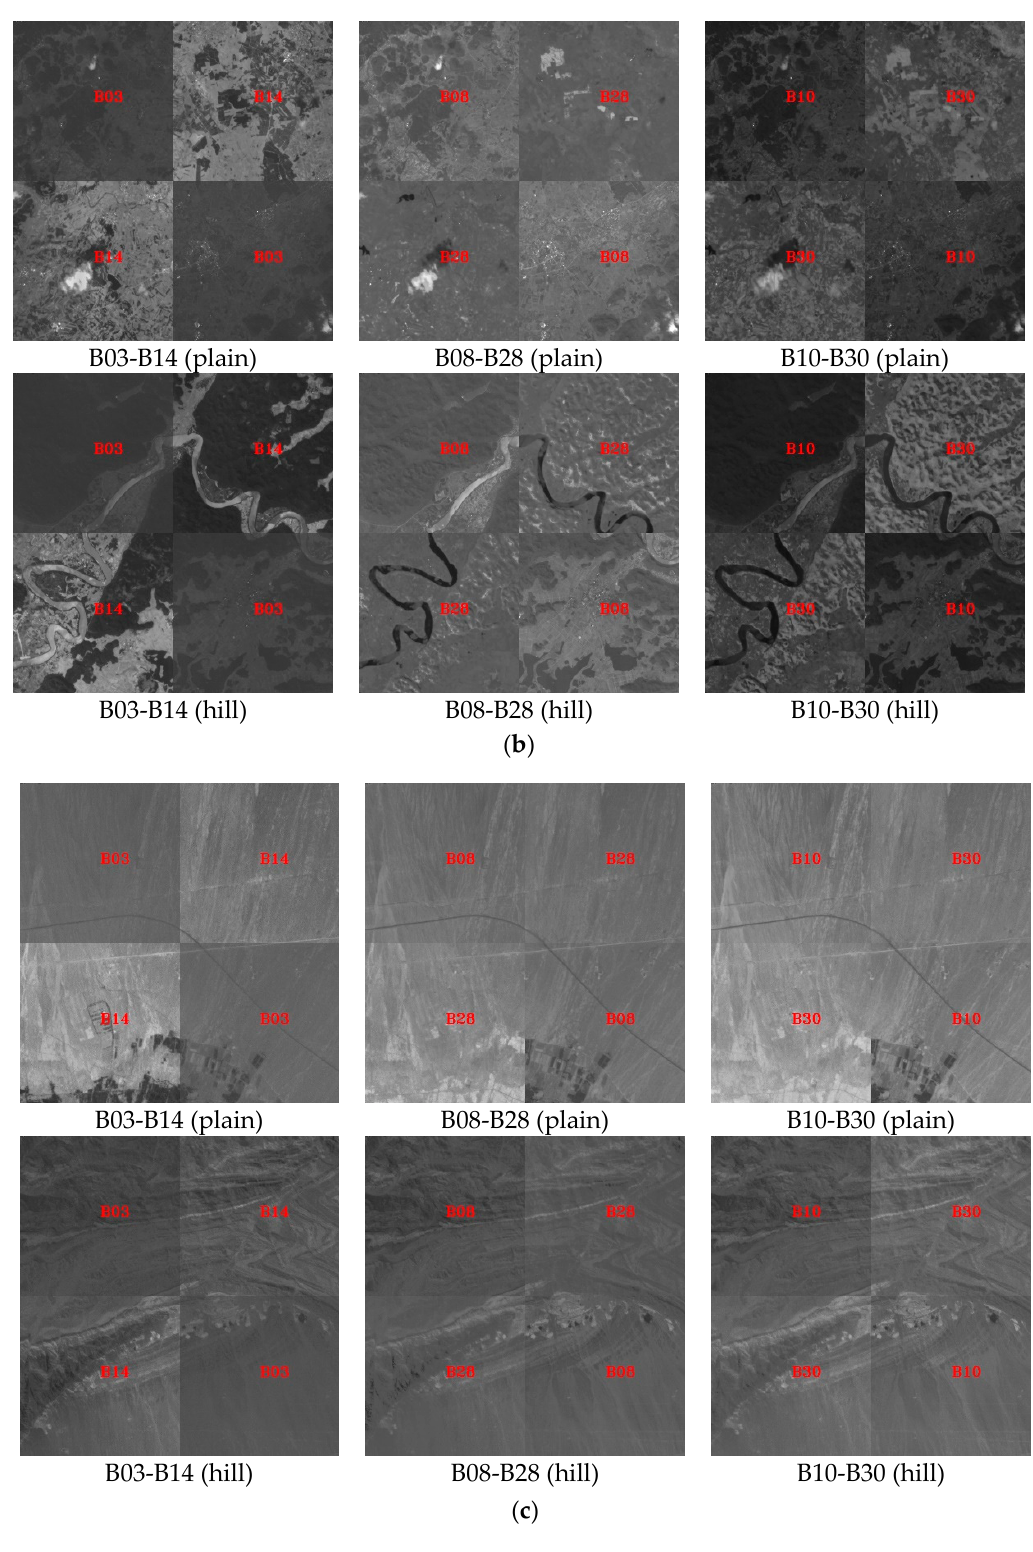
Figure 9. Local comparison of registration results between different bands. ( a ) OHS–Arizona, USA; ( b ) OHS–Guangxi, China; ( c ) OHS–Xinjiang, China.